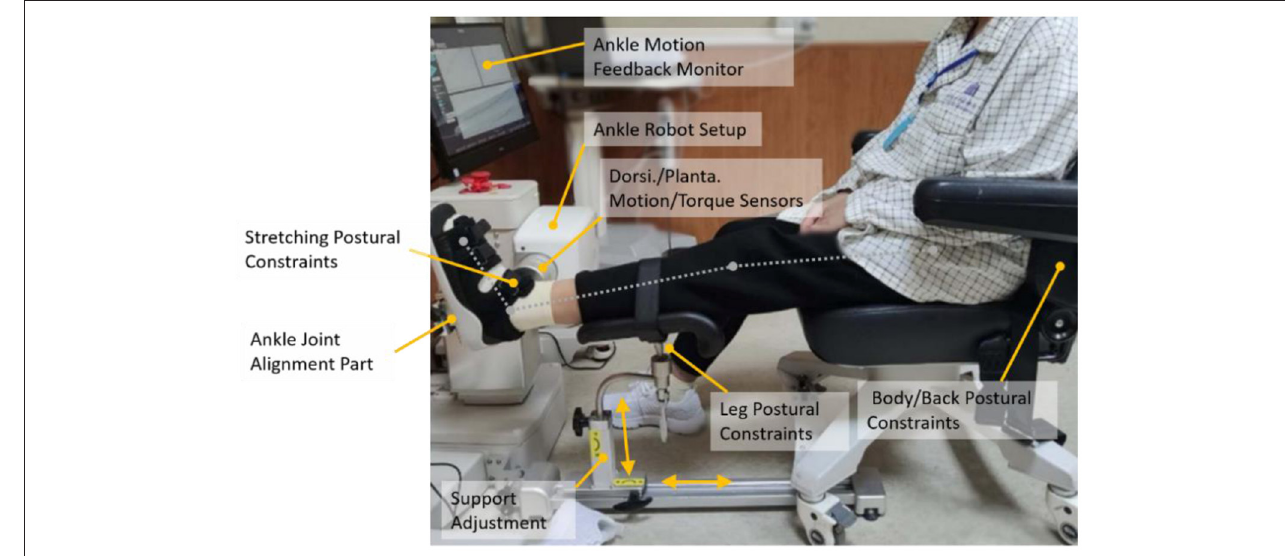
FIGURE 1 | A subject seated in the ankle rehabilitation robot